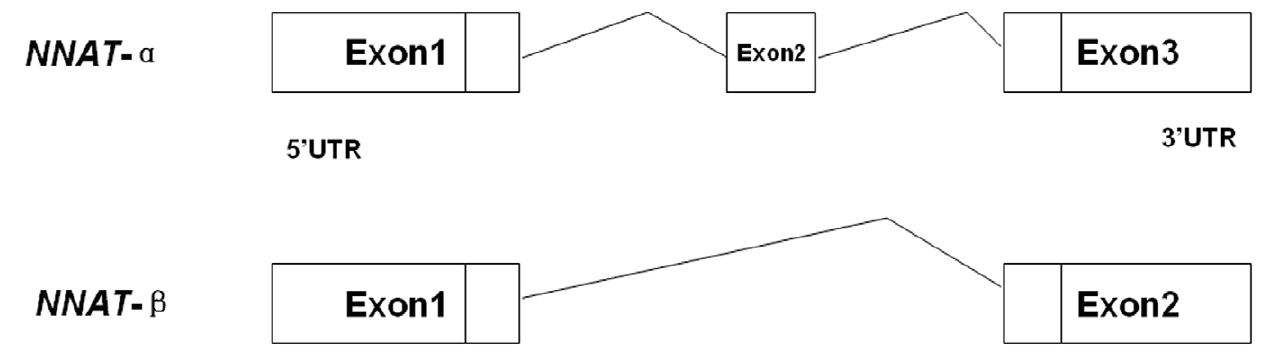
Figure 1. Two transcripts of porcine NNAT . NNAT - a had three exons, while NNAT - b lacked the second exon, which consisted of 81 base pairs.